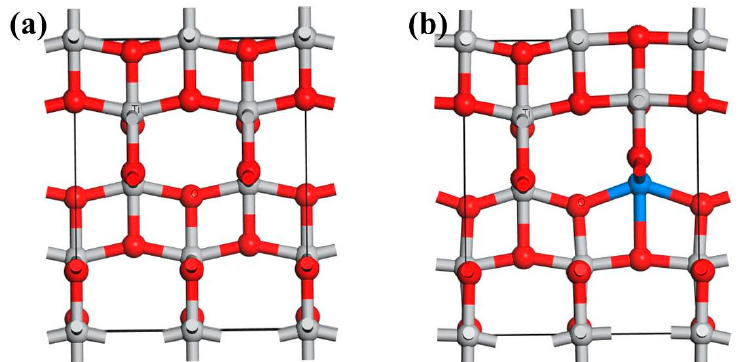
Figure 1. A 3-D model of anatase TiO 2 ( a ) and with rare earth metal dopant ( b ); blue atom is a rare earth metal atom.